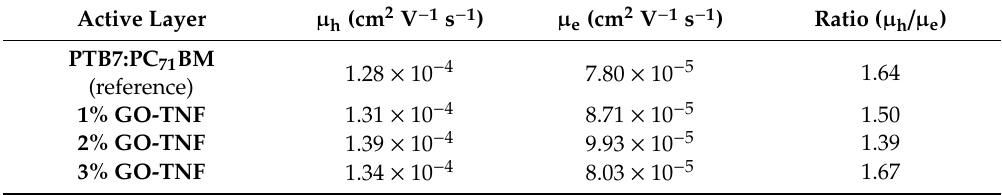
Table 2. Hole and electron mobilities of PTB7:PC 71 BM and ternary blend PTB7:GO-TNF:PC 71 BM *. Active Layer